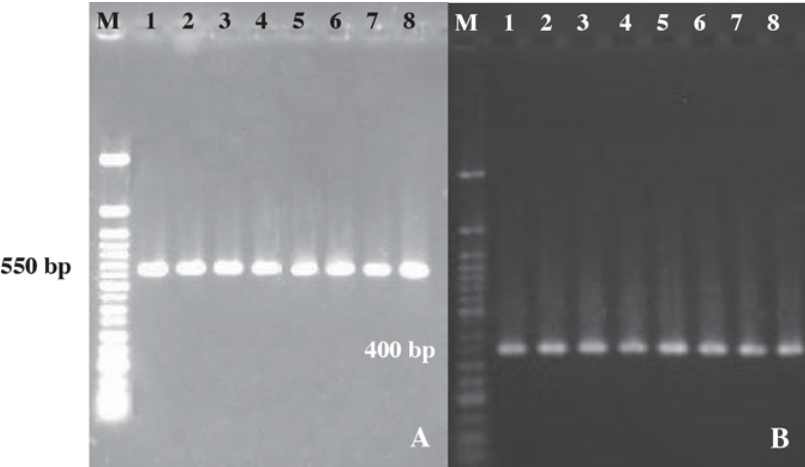
Fig. 2. PCR detection of Pectobacterium carotovorum subsp . carotovorum with specific primer pairs. Primer sets EXPCCF/EXPCCR and INPCCF/INPCCR were used for standard PCR (A) and nested PCR (B), respectively. Aliq- uots of 15 µl from each amplified PCR mixture were separated by electrophoresis on 1·5% agarose gel. Lane M, 50 bp DNA ladder. Lane 1–8, bacterial